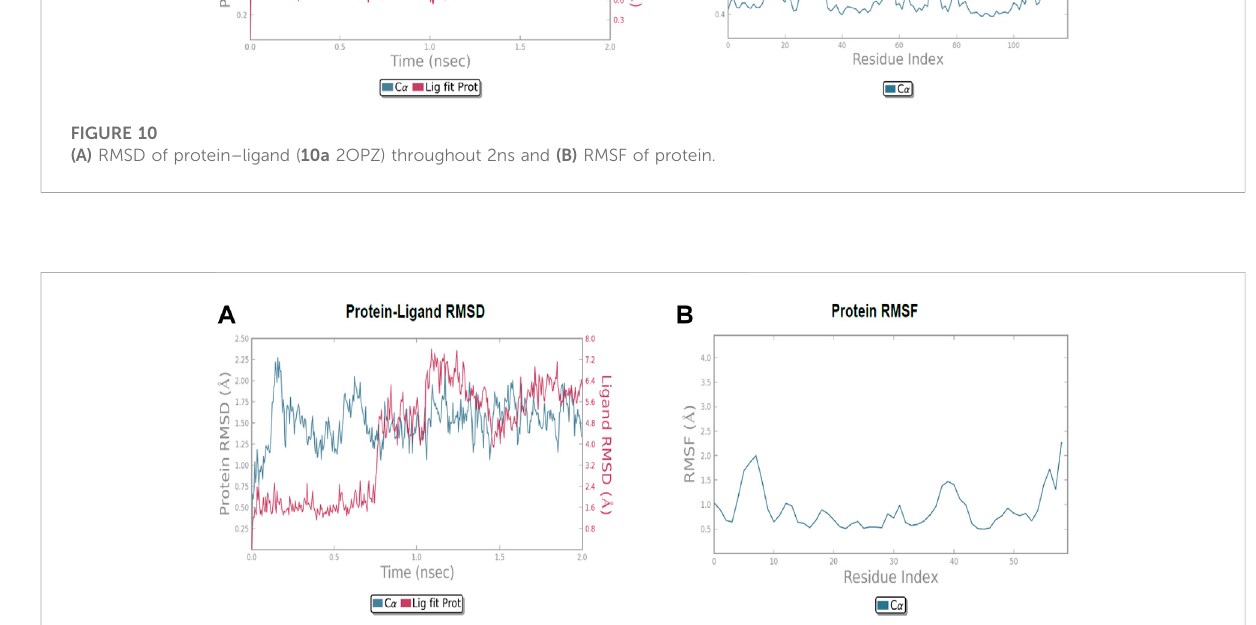
FIGURE 11 (A) RMSD of protein-ligand (6b 2OPZ) throughout 2ns and (B) RMSF of protein.